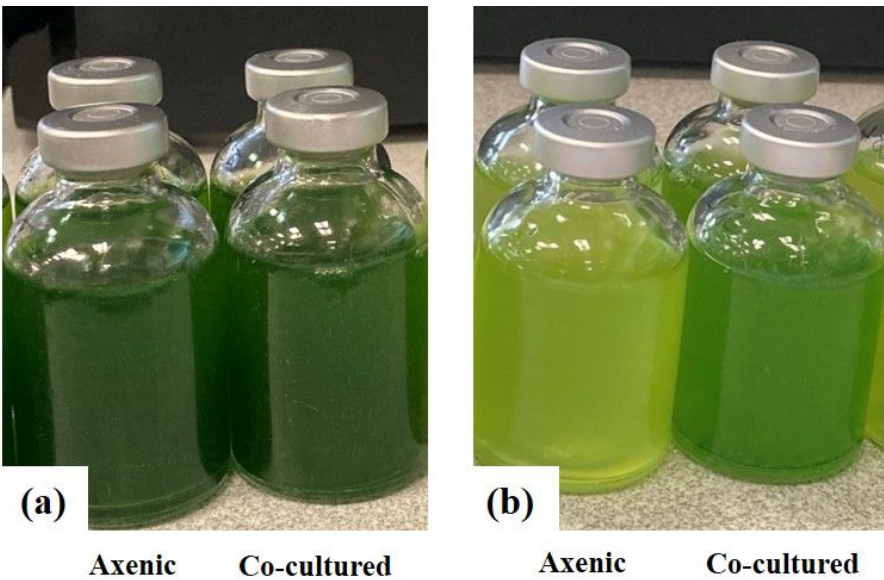
Figure 4. Chlorella sp. MACC-360 cultivation in TAP ( a ) and TP ( b ) media supplemented with 8 g L −1 starch (the initial bacterial OD 600 of 0.07). Axenic and co-cultured algae are shown. Images were taken on the 7th day of growth.